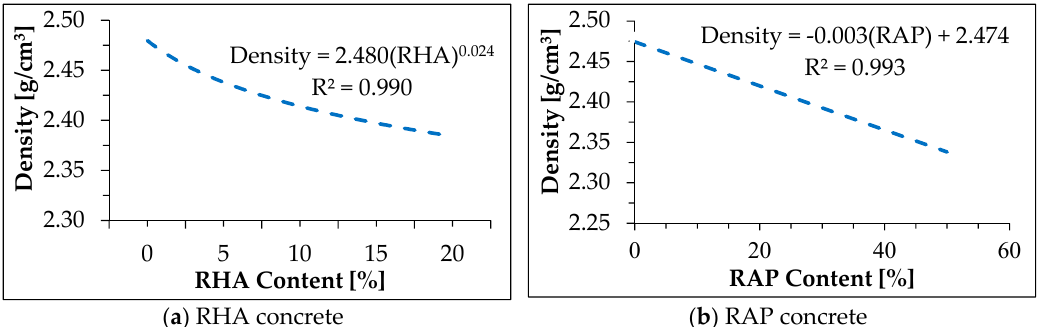
Figure 6. Fresh density for RHA and RAP concrete.